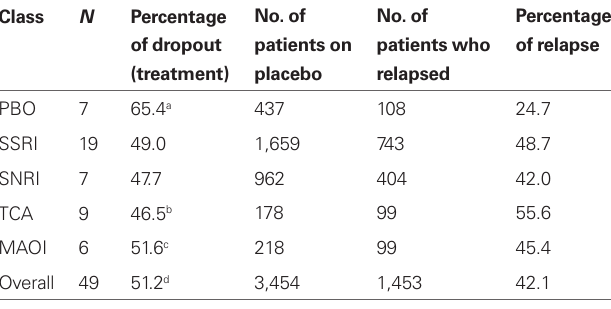
c Based on two of the six samples. d Based on 39 of the 49 samples.